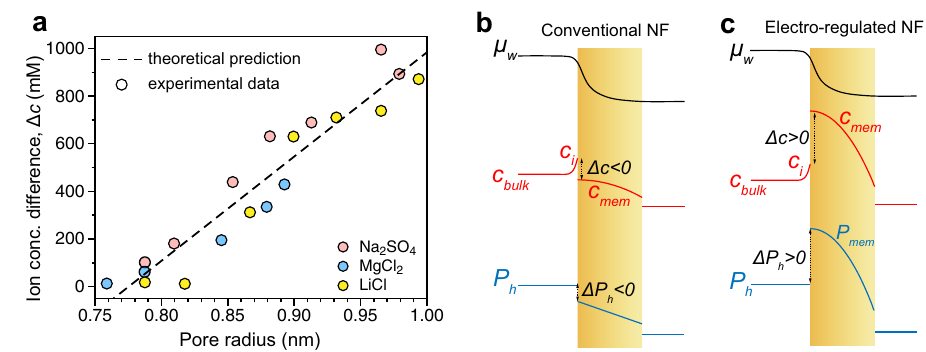
Fig. 4 | Mechanism of electrically induced osmotic pore size regulation. a Correlation between ion concentration differences (i.e., concentration in the networkminustheinterfacialconcentrationinthesolution)andporeradiiforthree different types of salts. The circles were deduced from experimentally measured data whereas the dashed line represents the correlation derived from theory. The